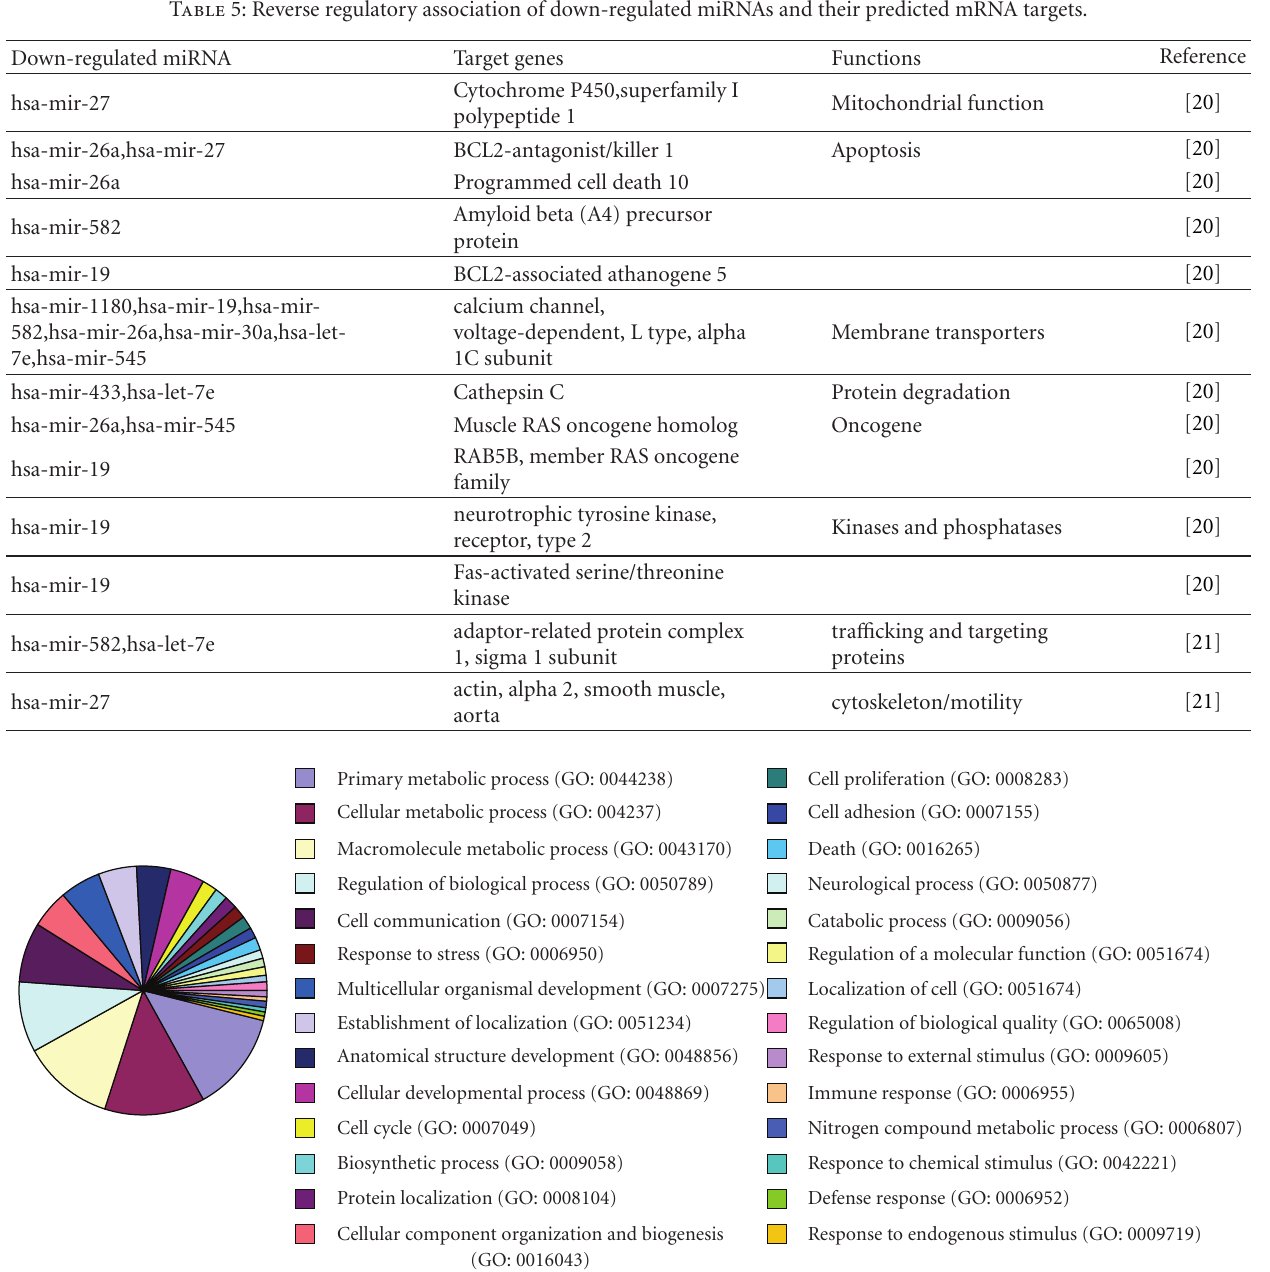
Figure 2: Predicted targets gene ontology terms in the biological process